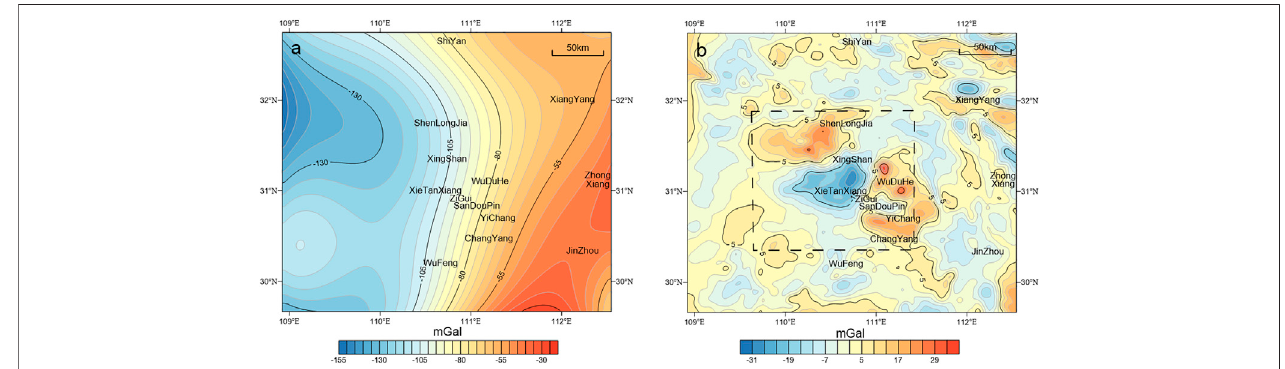
FIGURE 4 | (A) Regional gravity anomalies and (B) local gravity anomalies in the Badong – Zigui area. The dashed line represents the inversion area.